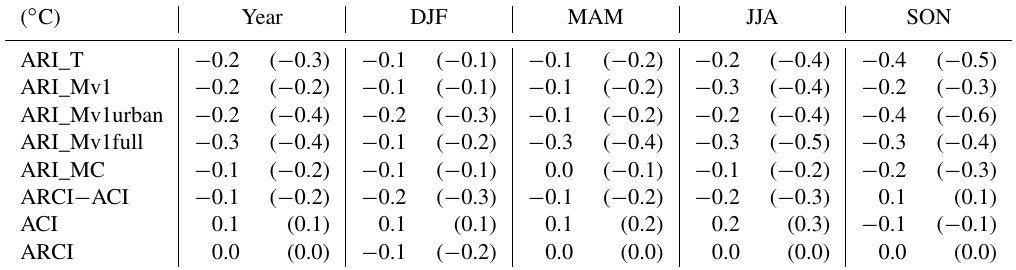
Table 3. Domain-averaged temperature difference ( ◦ C) compared to CON for all experiments and seasons. In parentheses are the values when only land points are considered. Where stated, for simulation ARCI the above quantities are also calculated against ACI (ARCI–ACI) in order to assess the implementation of the direct effect in the Thompson aerosol–cloud interacting cloud